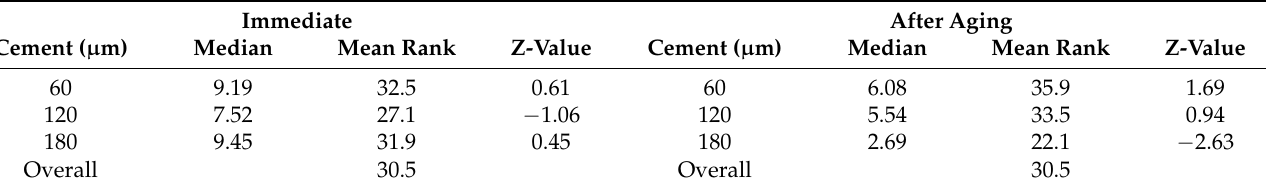
Table 3. Descriptive statistics from Kruskal–Wallis tests (MPa versus Cement